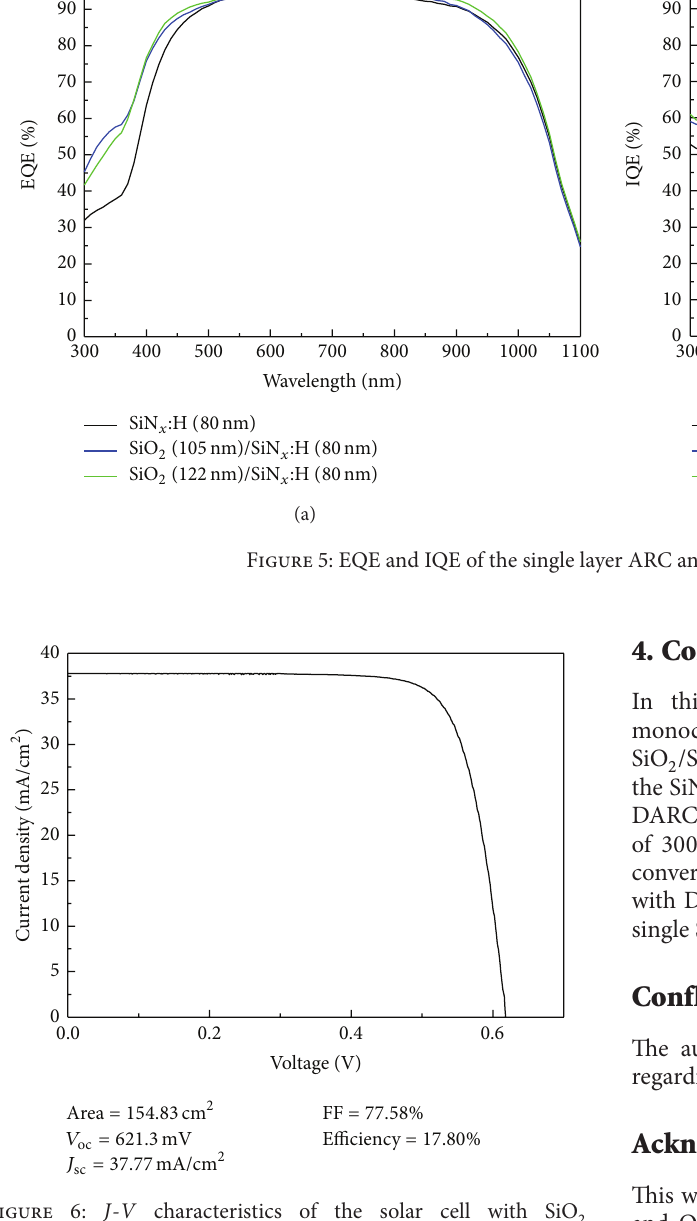
with SiN :H SARC. The fill factor of each group is nearly the x shows small degradation for solar cells, same, while the 𝑉 oc which probably caused by the surface damages during the e- beam